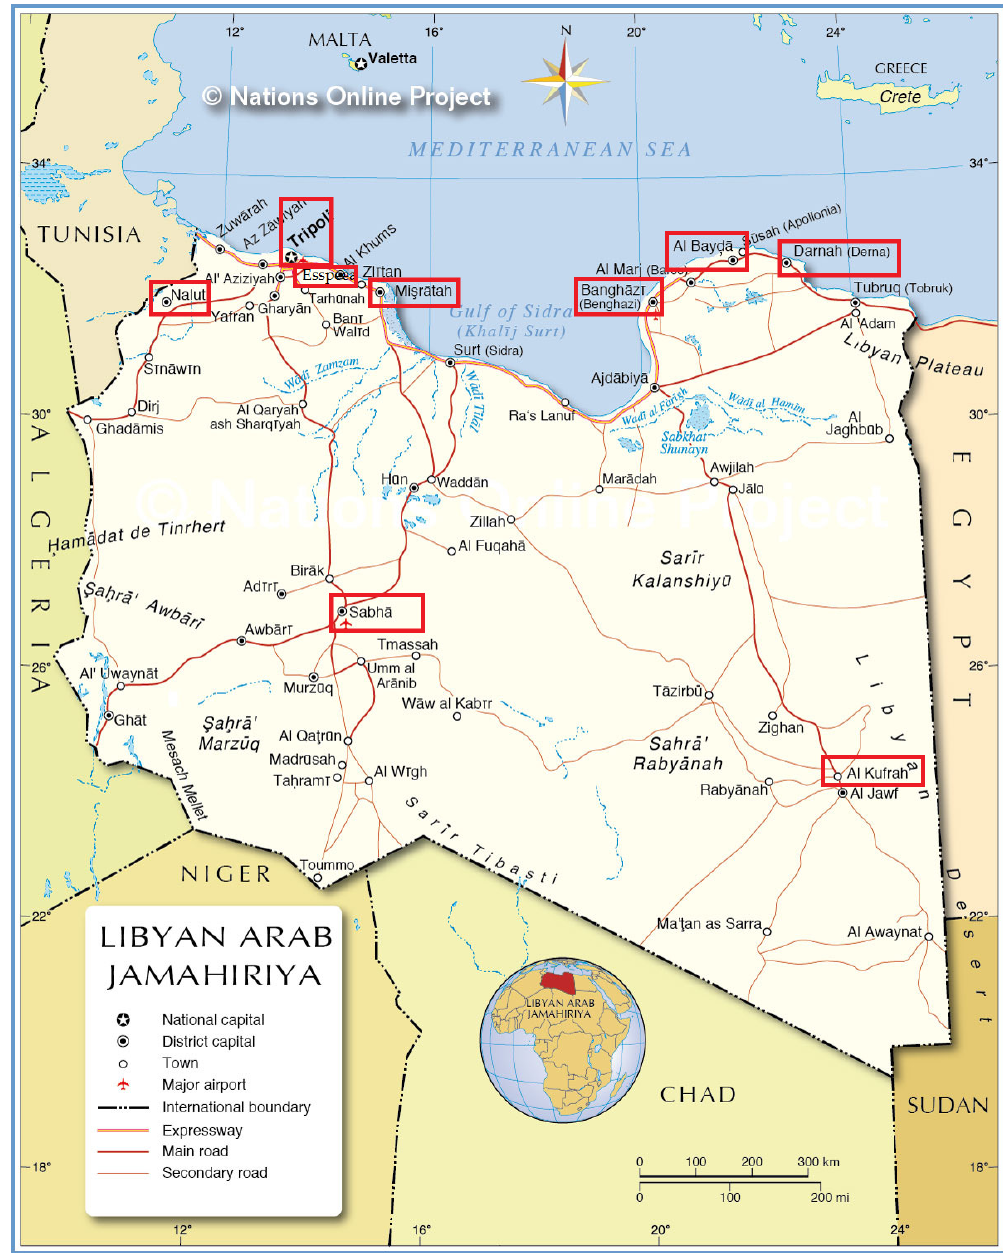
Figure 2. Map of Libya.